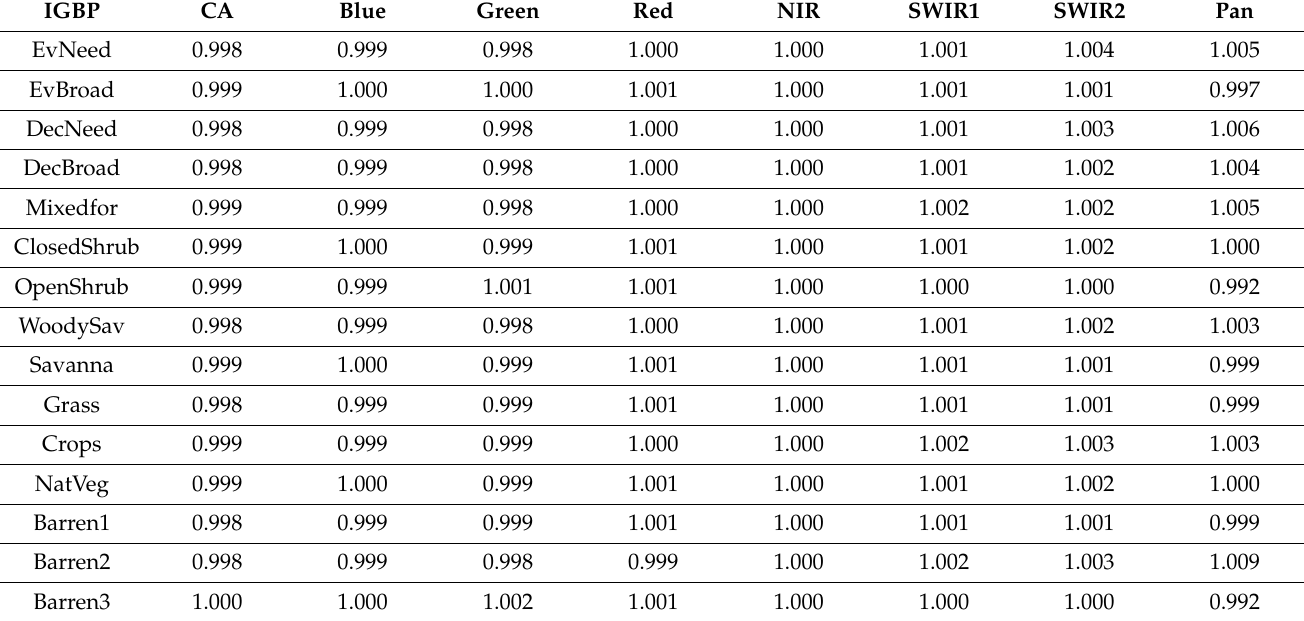
Table 7. SBAFs for each of the IGBP land cover types.